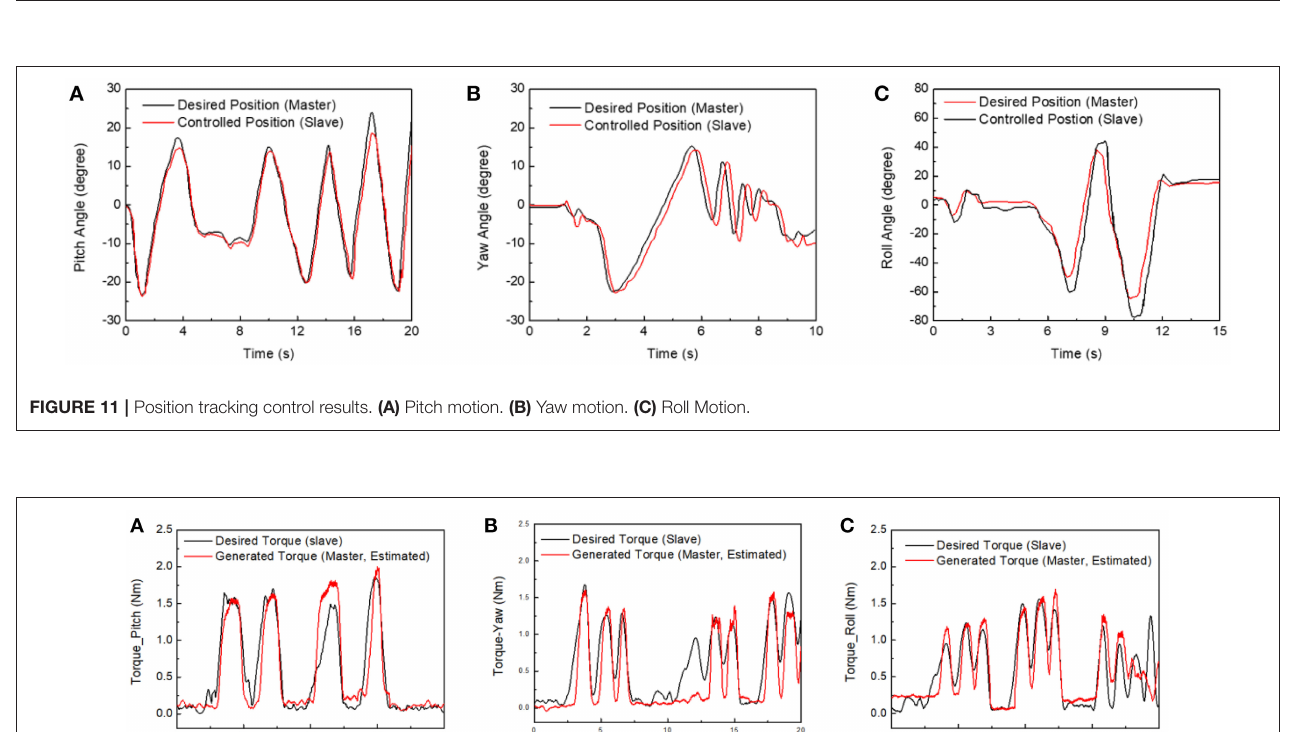
FIGURE 10 | Membership function of the fuzzy algorithm. (A) Input e ( k ). (B) Input 1 e ( k ). (C) Output K P . (D) Output K D . (E) Output α .